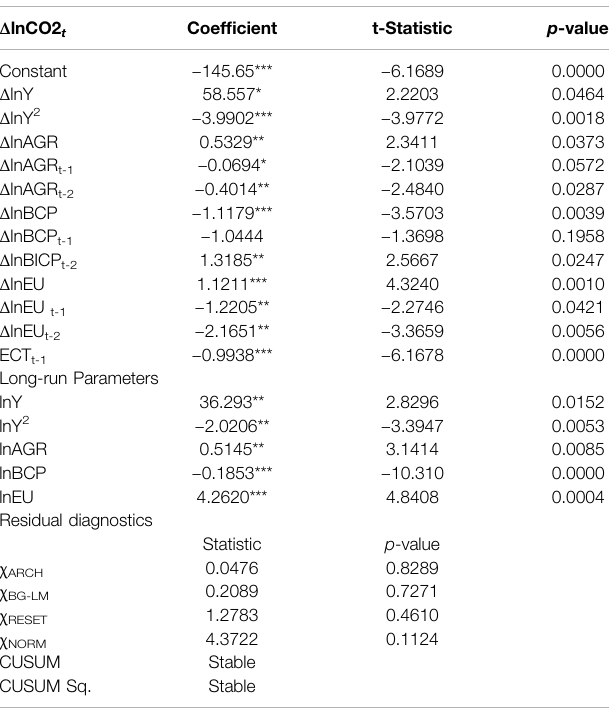
TABLE 6 | ARDL parameter estimates. TABLE 7 | Result of causal relationship